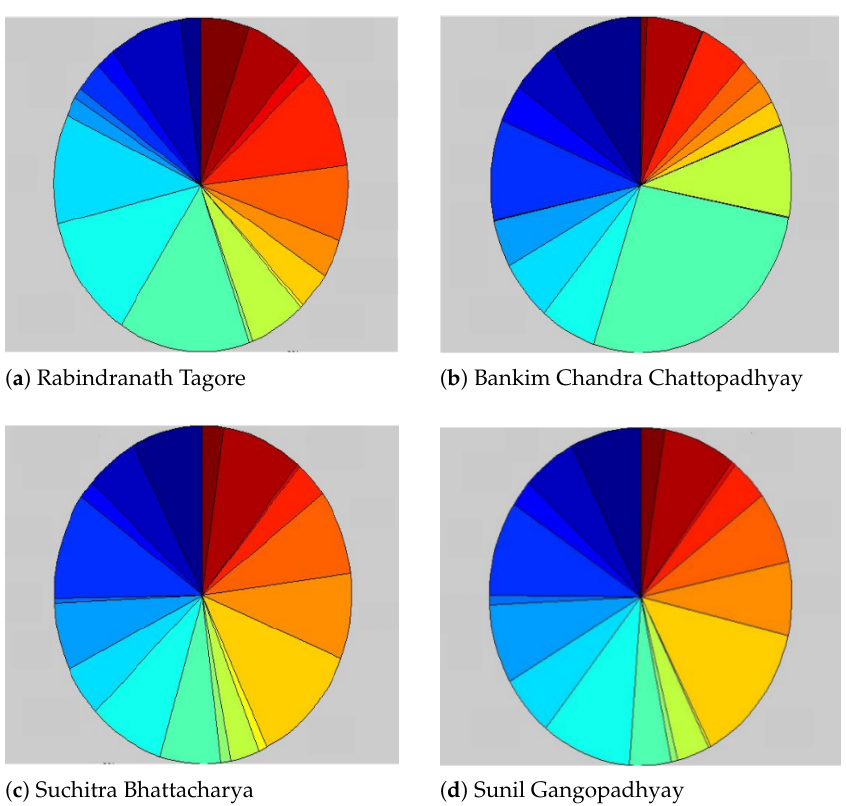
Figure 8. The feature visualizations of one document by four authors using pie charts. Each area represents each feature value obtained for 17 features used in the experiment. Here, the “hsv” theme was used for distinguishing the feature values from one